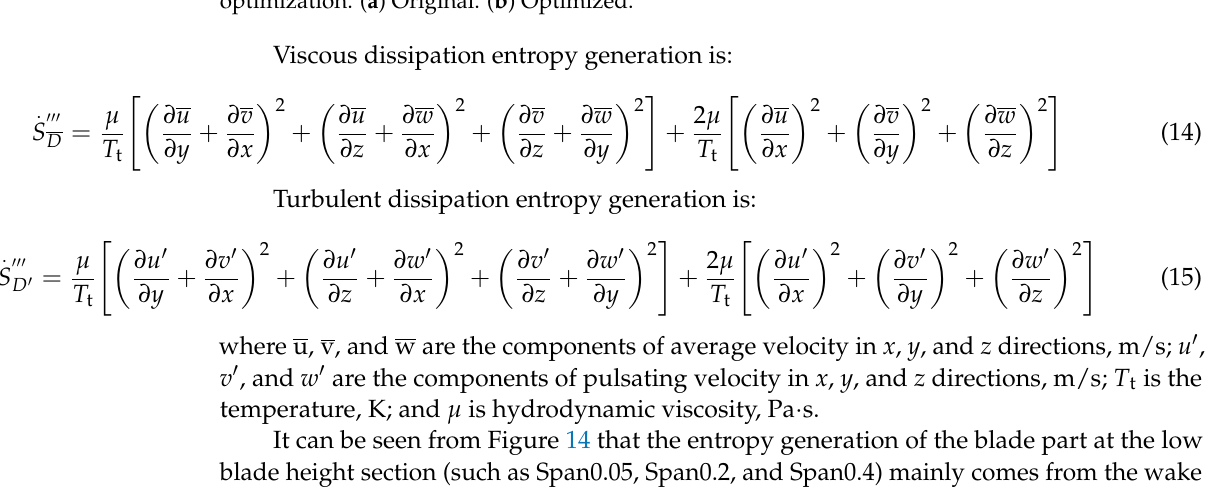
Figure 14. Cross-section entropy cloud diagram of different fan blade heights before and after optimization. ( a ) Original. ( b )